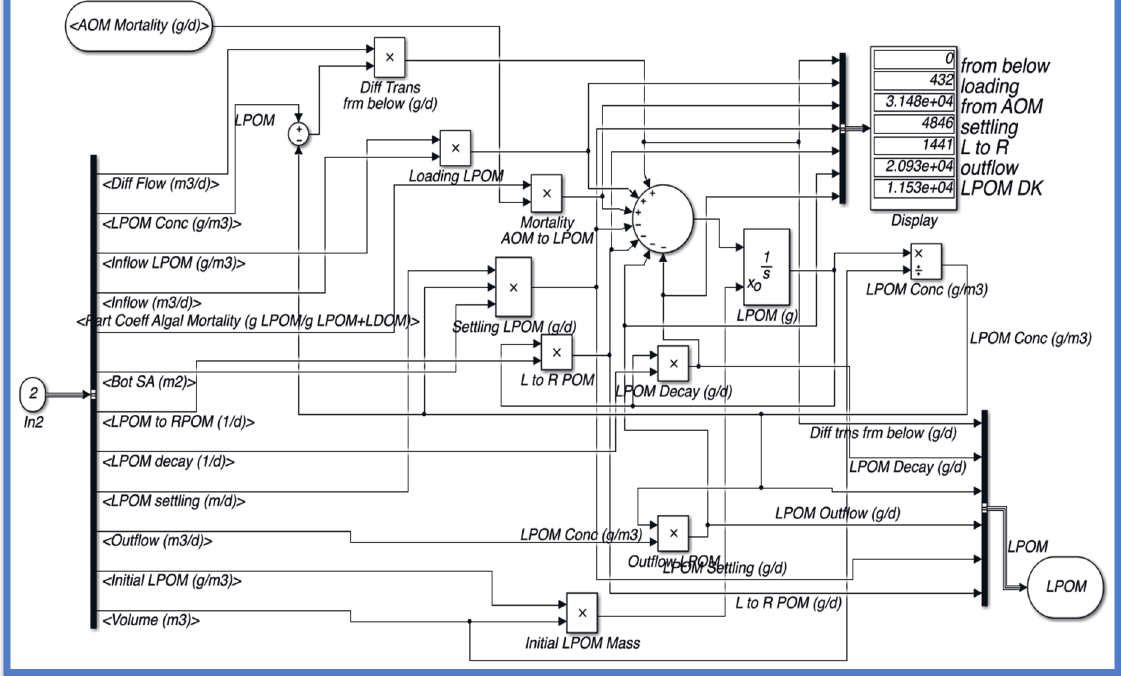
Figure 10. Labile particulate organic matter (LPOM) constituent found with the nutrient mass balance subsystem within each segment and layer as executed in